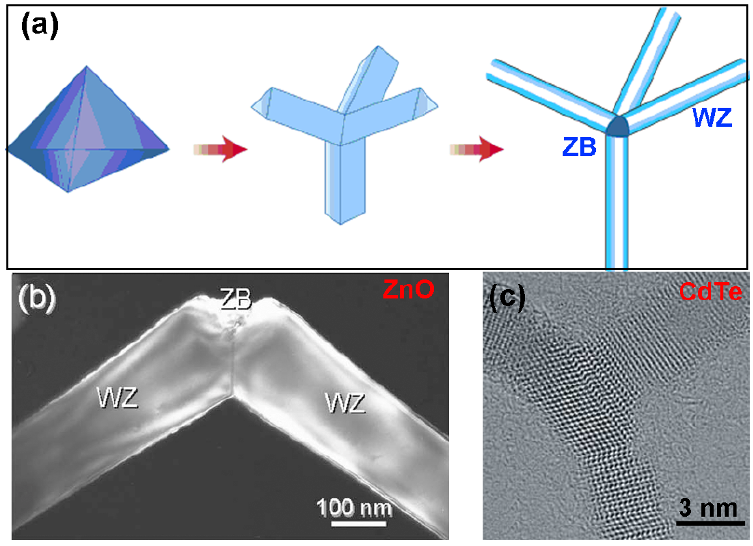
Figure 3. Phase transition introduced branching. (a) The mechanism is schematically shown, where the WZ branches grow from a ZB core [19]. (b) Similar branch